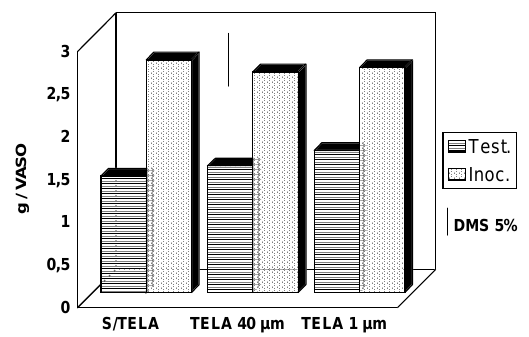
tela.Figura 3. Matéria seca da parte aérea do milho, inoculado (Inoc.) ou não (Test.) com Glomus etunicatum, nos vasos com tela de 1 µm, 40 µm e sem